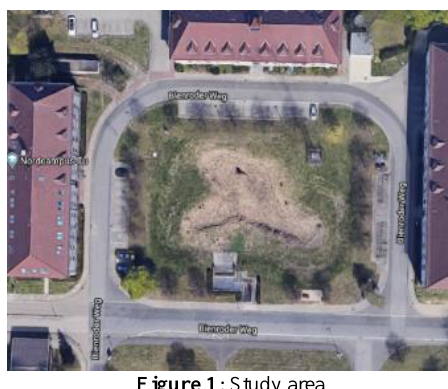
radio tower inside this study area makes flights in low altitude (less than 50 meters) impossible/unsafe. Images from this area are taken from a DJI Phantom 4 RTK drone equipped with an RGB camera FC6310R with resolution of 5472 × 3648, and the focal length of 8.580 mm. The utilized scale-bars are classical levelling bars with photogrammetric coded targets at the both ends (Figure 2). The calibrated distance between coded targets on each scale-bar is measured using AICON DPA system with a precision of 50 µm. In the field we distributed points which were measured with a total station in a local area network